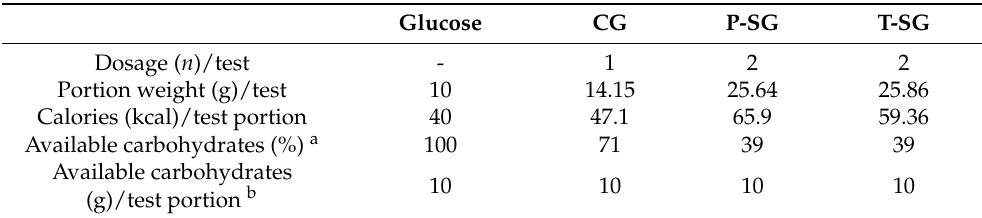
Table 6. Energy per gummy sample and reference glucose for each